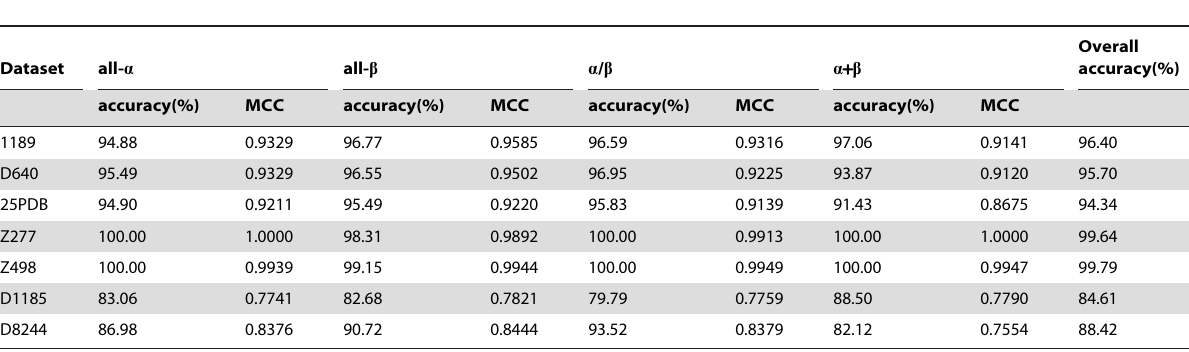
Table 2. Prediction performances on seven datasets by our method.